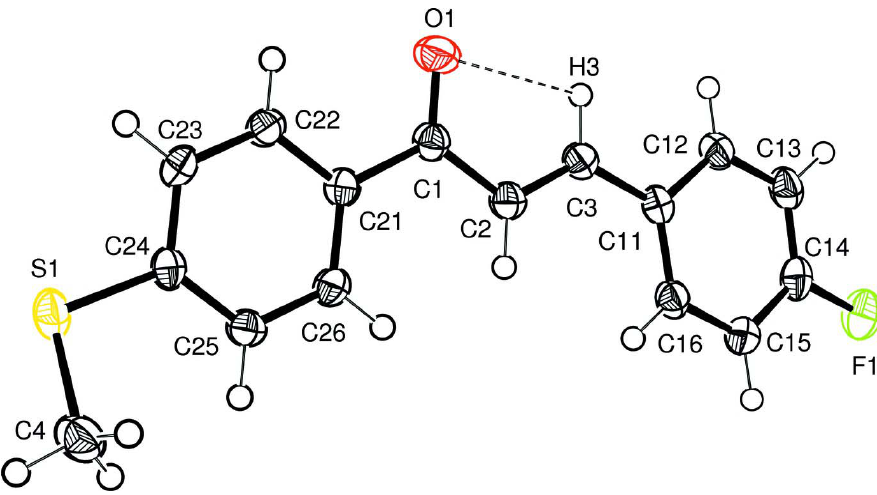
Figure 1 The molecular structure of the title compound, showing the atom-numbering scheme and displacement ellipsoids drawn at the 50% probability level. H atoms are shown as small spheres of arbitrary radius. The dashed line indicates a short intramolecular